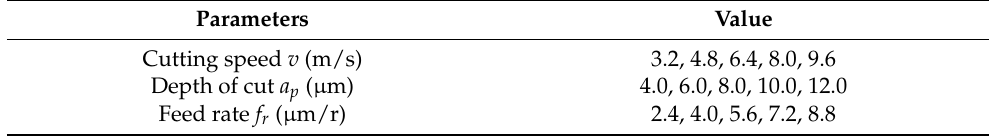
Table 1. Single-point diamond-turning parameters.